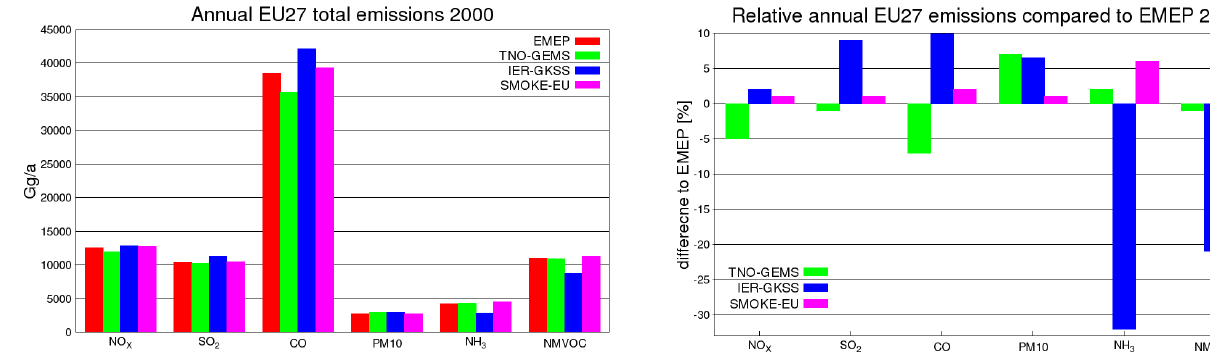
Fig. 5. Annual total emissions of the EU27 (biogenic emissions are not included) relative to those of EMEP. Data for different emission datasets for the year 2000 on a 54 × 54km 2 domain (Fig.